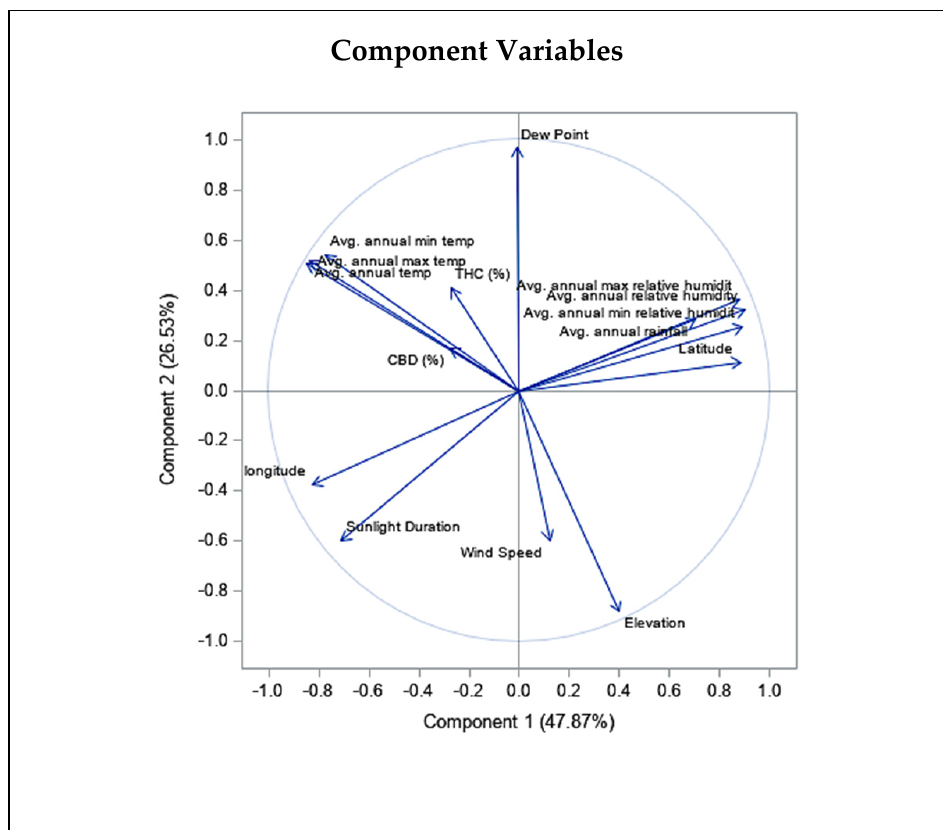
Figure 4. Principal component biplot consist of PCA scores of individuals (dots-first graphic) and loadings of variables (vectors-second graphic) of THC and CBD contents of 20 Iranian cannabis populations and geographical/climatic variables of regions of origin. PC1 and PC2 explain most of the variance in the original variables. Average annual temperature and latitude strongly influences PC1, while elevation and sunlight duration have more say in PC2. The loading plot shows THC and CBD contents positively correlate with mean, min, and max annual temperature and negatively correlate with elevation, latitude, and humidity statistics.